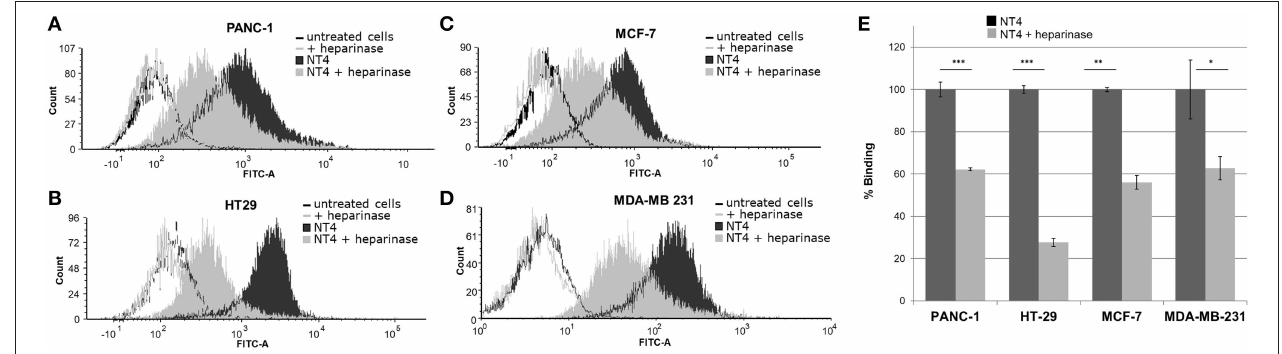
FIGURE 1 | (A–D) NT4 binding to PANC-1, HT-29, MCF-7, and MDA-MB-231 cancer cells before and after heparinase I/III treatment, tested by flow cytometry. (E) Variation of binding of NT4 after heparinase treatment, 100% (dark histogram) is the baseline binding of NT4 to the different cell lines *** p < 0.001, ** p < 0.01, * p < 0.05 by Student’s t